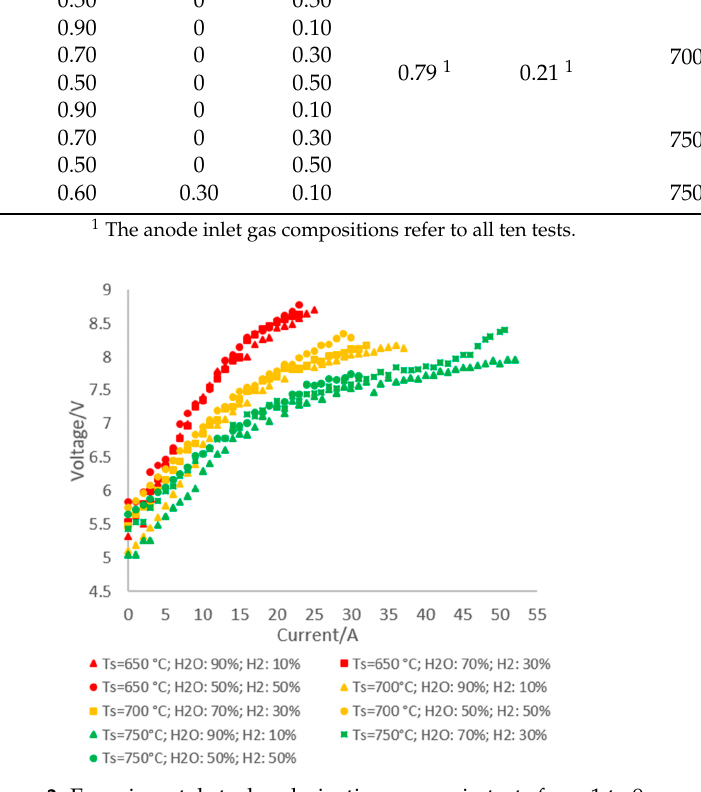
Figure 3. Experimental stack polarization curves in tests from 1 to 9.